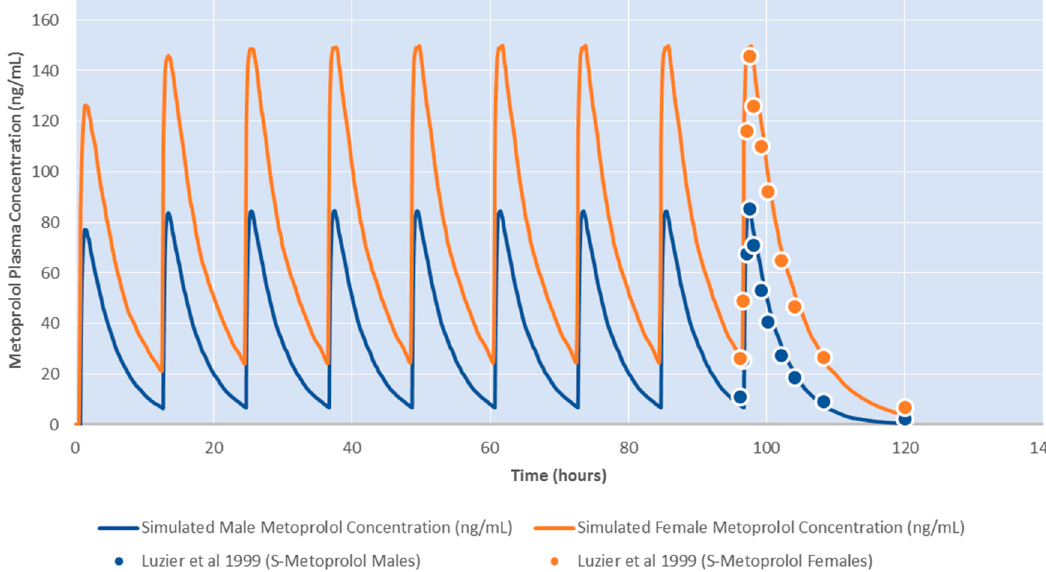
Figure 2. Model parameter validation using pharmacokinetic dosing simulations using the gender-stratified model parameters and the original Luzier et al. experimental plasma concentrations. Female ( orange —higher line) and male ( blue —lower line) dosing simulations for the nine 100 mg metoprolol doses illustrate an adequate fit to the experimental results.